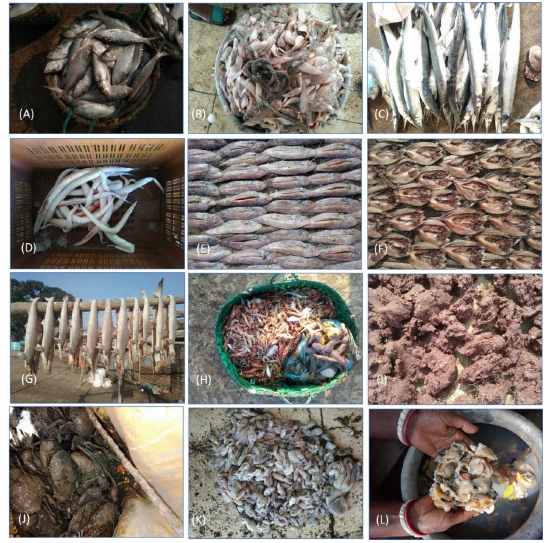
Figure 3. Fishery resources with multidimensional uses (provisioning services) in the studied south-eastern coastal areas of Bangladesh: ( A ) Hilsa shad species Tenualosa ilisha (Hamilton, 1822)—Ilish, the national fish of Bangladesh; ( B ) Bombay duck, Harpadon nehereus (Hamilton, 1822)—Loitta fish waiting for sale, usually used for raw and dried food items; ( C ) harvested Indian pike conger, Congresox talabonoides Bleeker—Kamila fish at the landing center, Moheskhali; ( D ) highly valued raw gas bladder of C. talabonoides ; ( E ) fishery products: Sun drying of Kukurjib fish—Gangetic tongue sole, Cynoglossus cynoglossus (Hamilton, 1822); ( F ) sun drying of Rupchanda —Chinese silver pomfret, Pampus chinensis (Euphrasen, 1788); ( G ) sun drying of Thuttre hangar—Spadenose Shark, Scoliodon laticaudus (Müller & Henle, 1838); ( H ) harvested catch—shrimp in the basket; (I) shrimp paste—Ngappi preparation in Moheshkhali; ( J ) Kakra/Haobba, mud crab, Scylla serrata (Forskal, 1775); ( K ) Cephalopods—Sepia, Loligo, Octopus often used as bait in long lining; ( L ) oyster used in food processing for food preparation (Photo credit: Shuvo Pal).